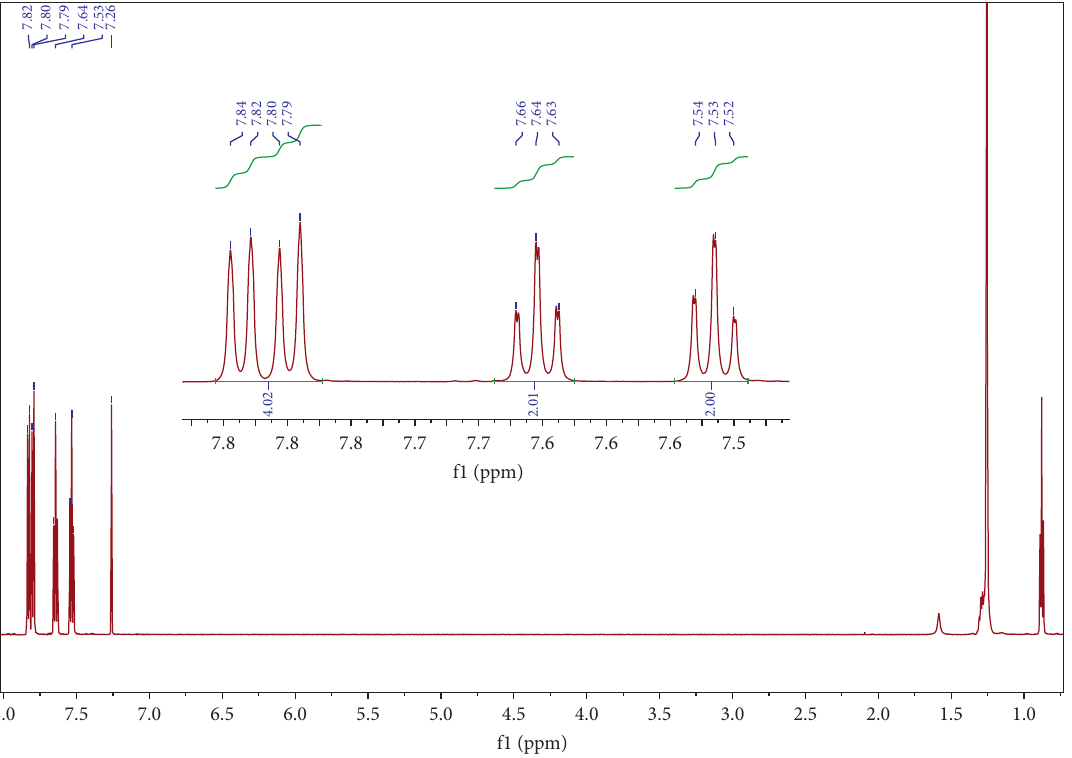
Figure 5: 1 H NMR of dibenzothiophene sulfone in CDCl